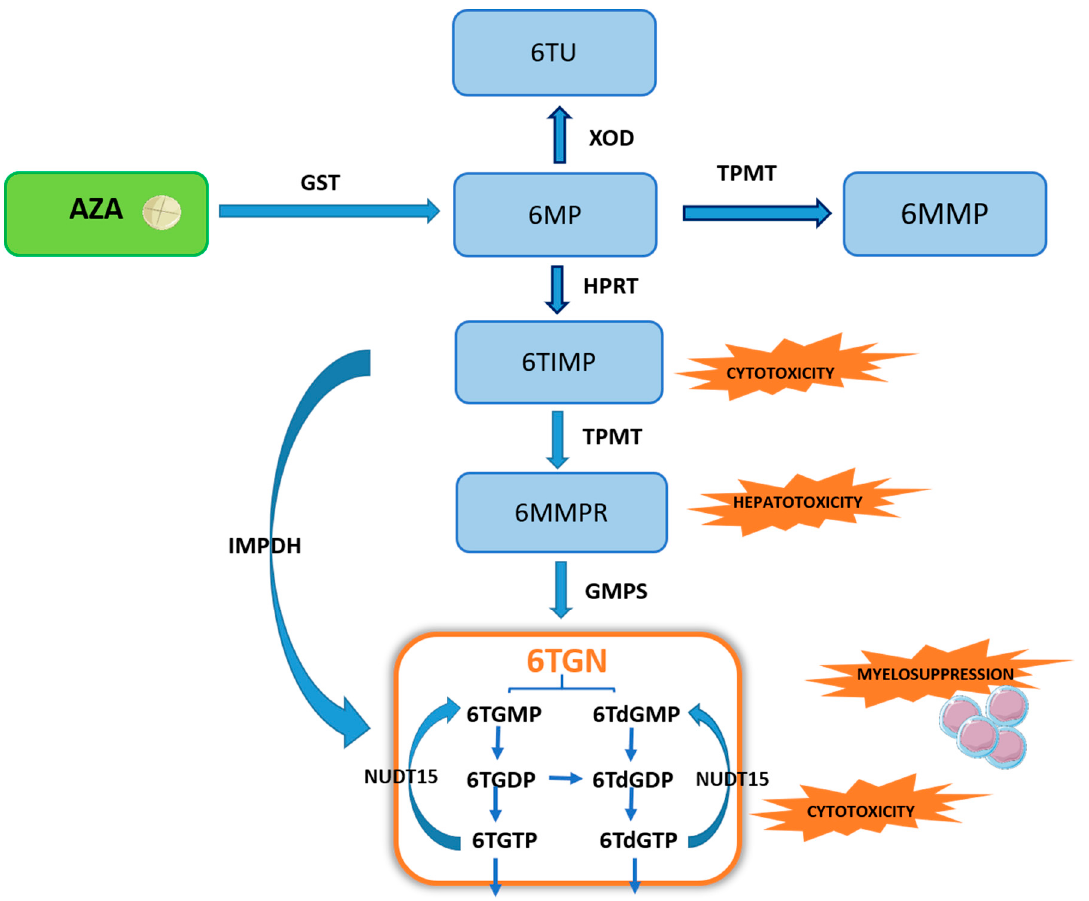
Figure 1. Scheme of the thiopurine biotransformation pathway. Explanation of abbreviations: AZA—azathioprine; GST—glutathione S-transferase; 6MP—6-mercaptopurine; XOD—xanthine